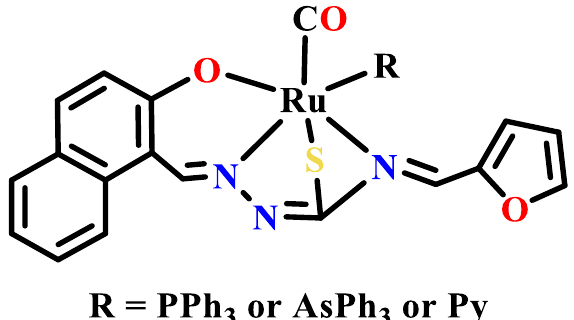
Figure 10. Three ruthenium(II) complexes of naphthalenehydrazone with α -furfuraldehyde amidyl thiourea.